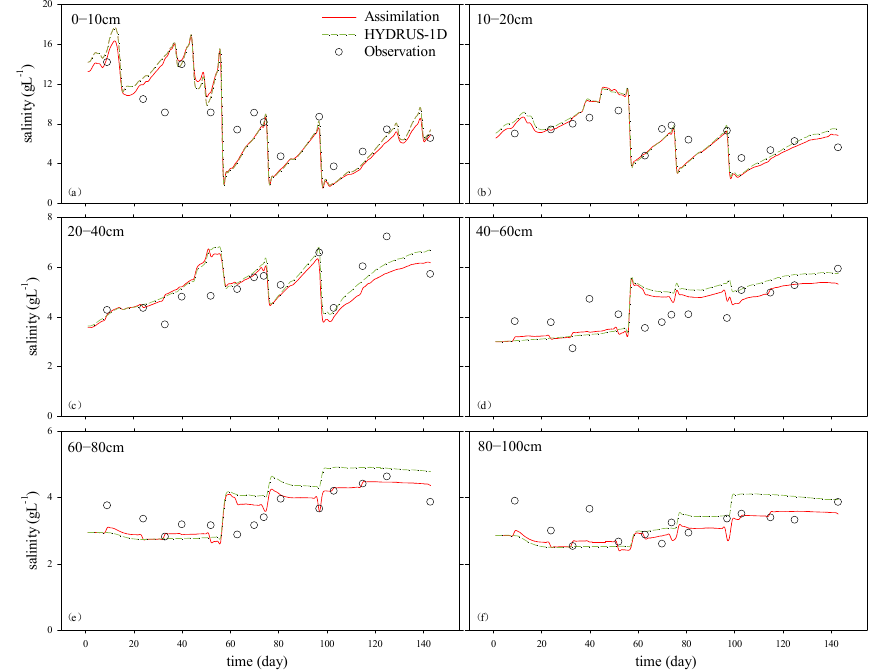
Figure 6. Simulated salinity at different depths with assimilation of the soil moisture and salinity. (Green dashed lines represent the simulated results from Ren et al. [34] obtained using HYDRUS-1D; red solid lines represent the assimilation results).